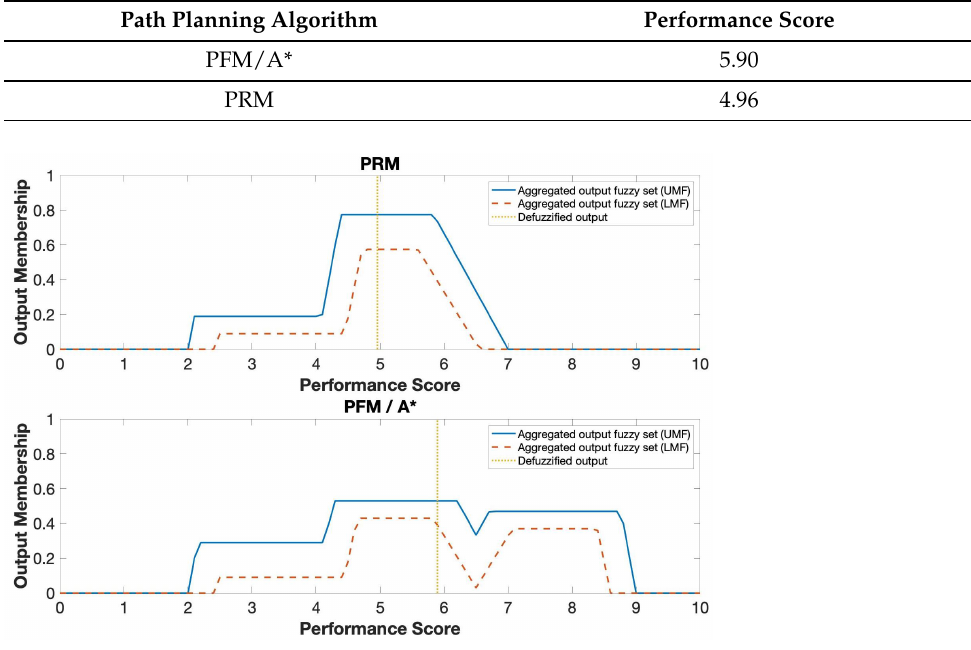
Figure 21. Output set for Case Study